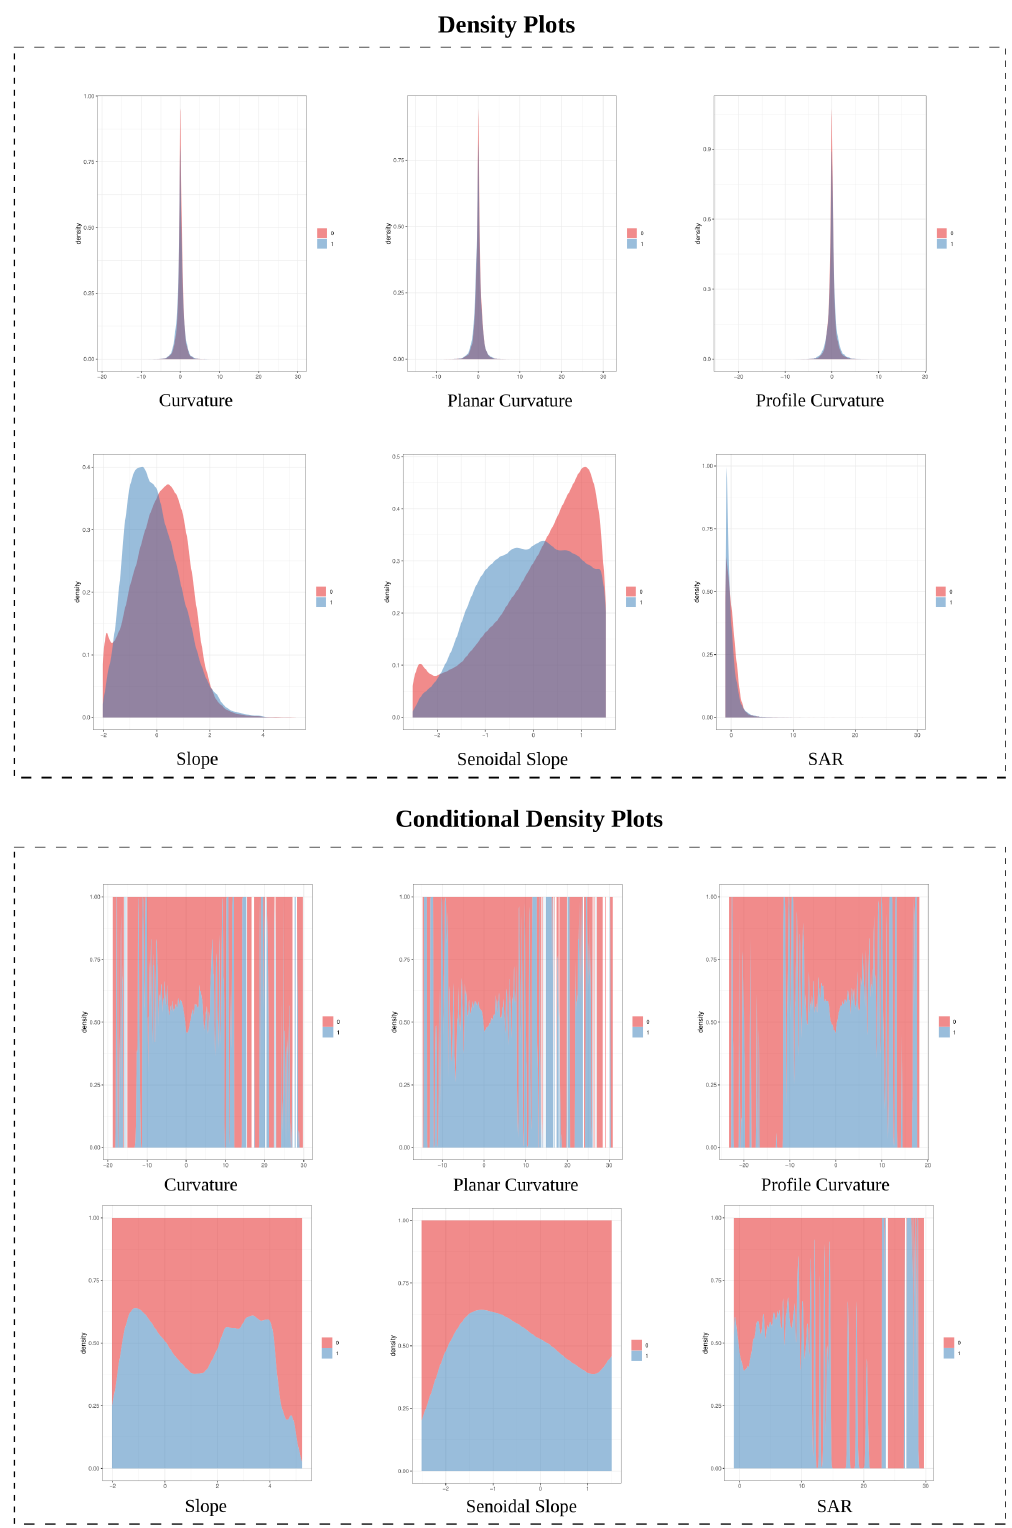
Figure 7. Density plots and conditional density plots for some continuous explanatory variables available in the Gipuzkoa study area.